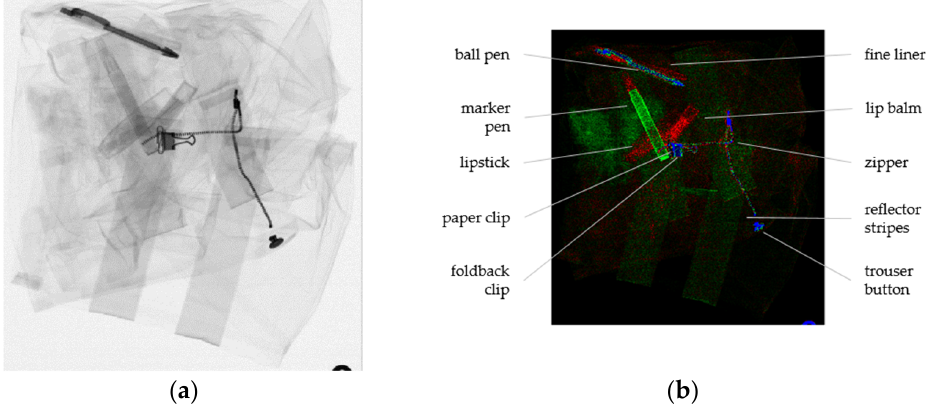
Figure 7. ( a ) High-energy image of the civil protection trousers; ( b ) False-colored combination of material images, red indicates Z eff = 6 (plastics), green Z eff = 13 (aluminum) and blue Z eff = 20 (calcium). As the second basis material, Z eff = 7.3 was used in all cases.